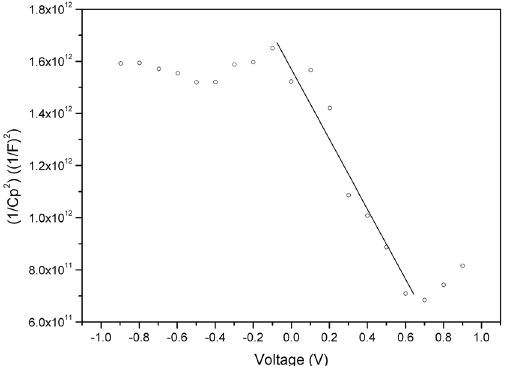
Figure 4. Characterization by